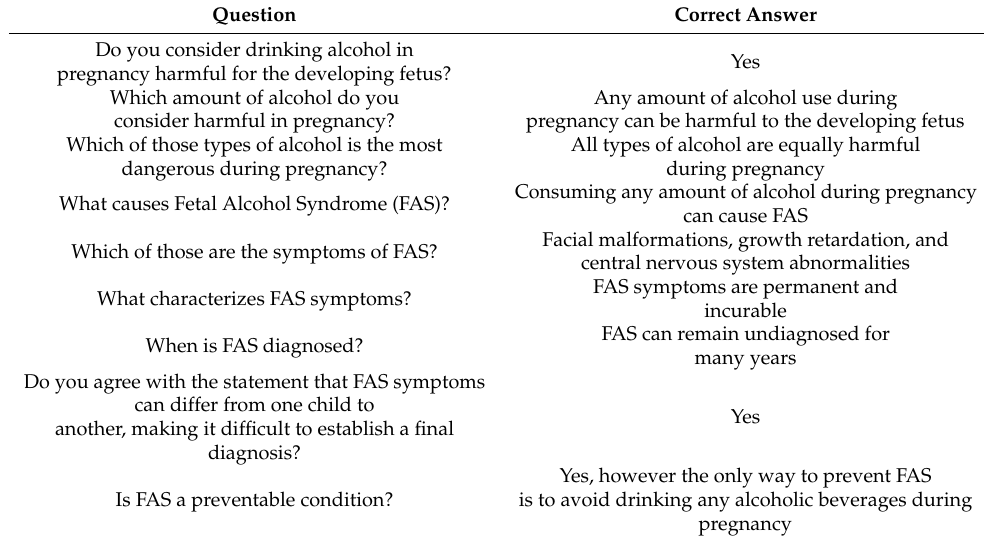
Table 2. Questions evaluating the level of knowledge about the effects of alcohol use in